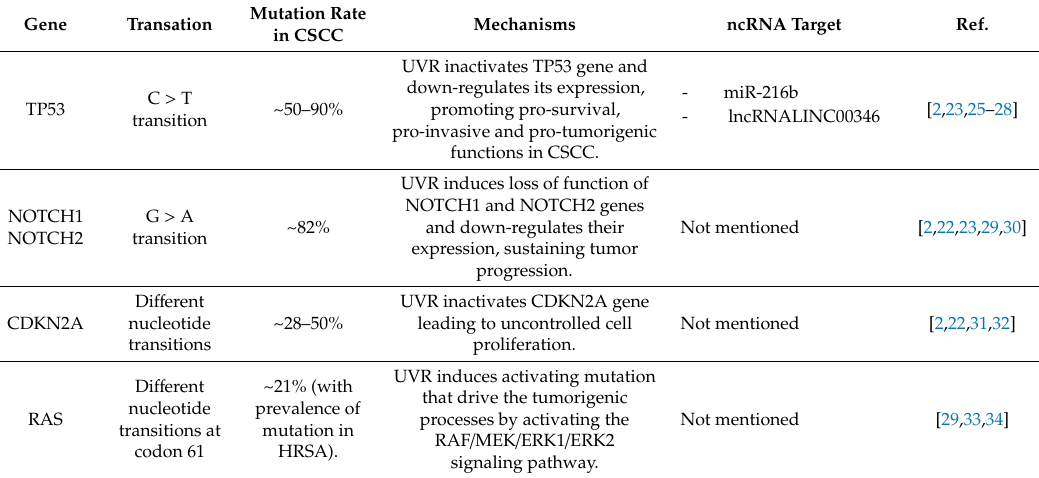
Table 1. The most common UV-induced gene mutations in